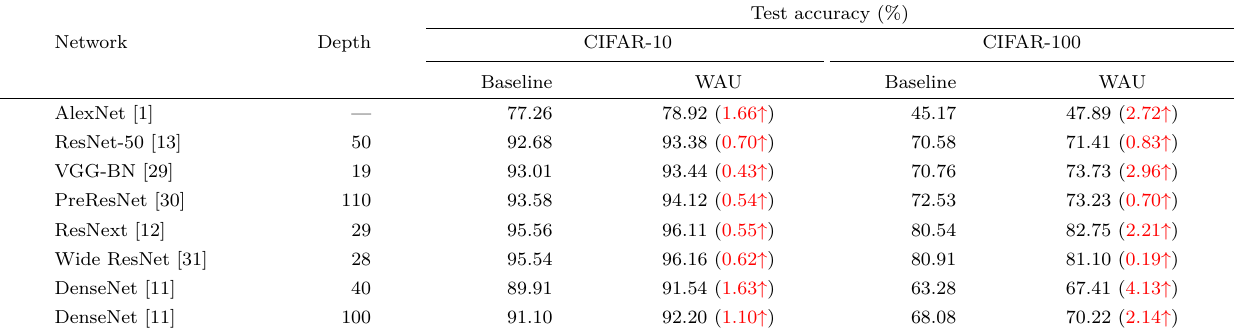
Table 1 WAU shows significant performance improvement over the baseline on both CIFAR-10 and CIFAR-100 (see Ref. [28], chap. 3)